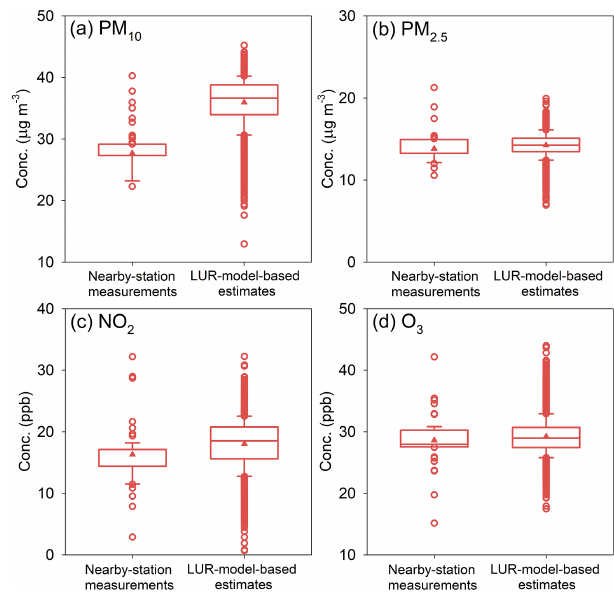
Figure 5. Box plots of nearby-station air pollutant measurements and LUR-model-based estimates of air pollutant concentration. (a) PM 10 , (b) PM 2 . 5 , (c) NO 2 and (d) O 3 . The triangle symbol in each box is the mean value, the solid line is the median value, the box extends from the 25th to the 75th percentile, the whiskers (er- ror bars) below and above the box are the 10th and 90th percentiles, and the lower and upper cycle symbols are